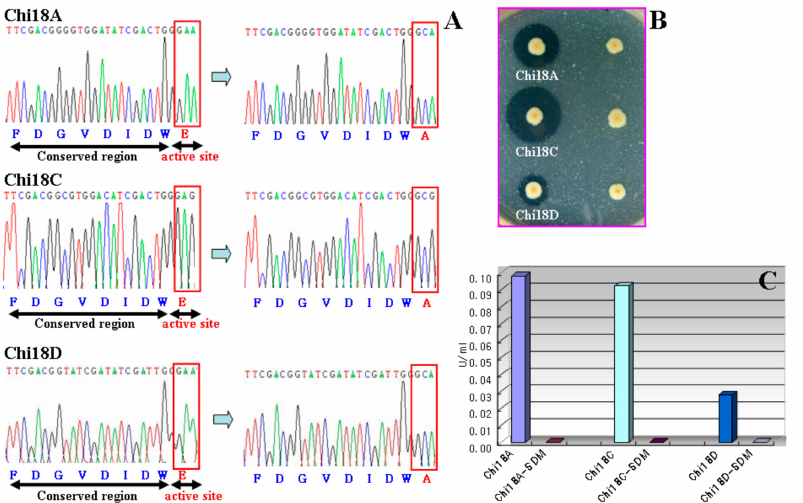
Figure 15. Confirmation of active sites of Chi18A, Chi18C, and Chi18D by site-directed mutagenesis. ( A ) Change of active site by site-directed mutagenesis from GAA and GAG (Glu) to GCA and GCG (Ala). ( B ) Chitinase activities of the mutants on an LBCC plate. ( C ) Chitinase activities of the crude extracts of the